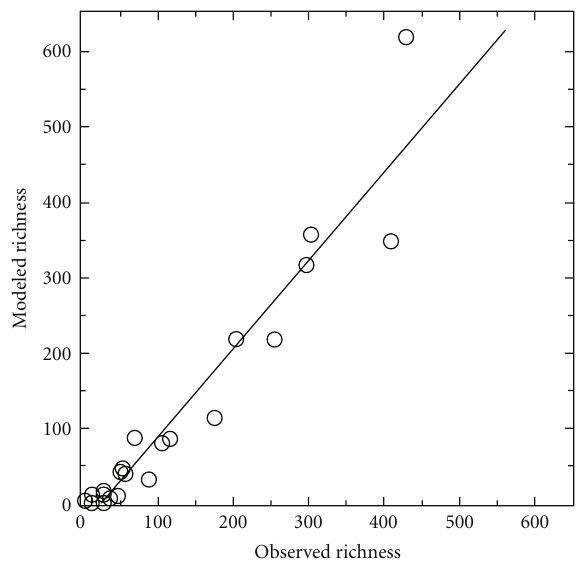
Figure 3: Modeled native plant species richness plotted against observe richness for 22 islands of the Gal´apagos Archipelago. A regression line provides reference ( r = 0.957, 60